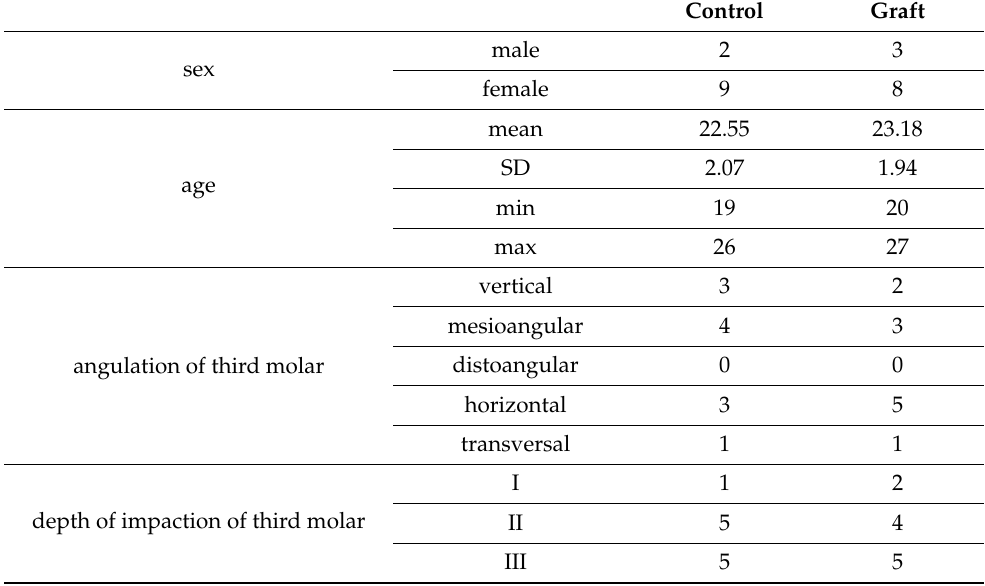
Table 1. Data of patients and the position of the third molars. Depth of impaction was classified according to Winter (1926) and Pell-Gregory (1942). The meaning of numbers: (I) third molar reaches occlusion; (II) third molar is between the occlusion and the neck of the second molar; and (III) third molar is below the neck of the second molar. Control